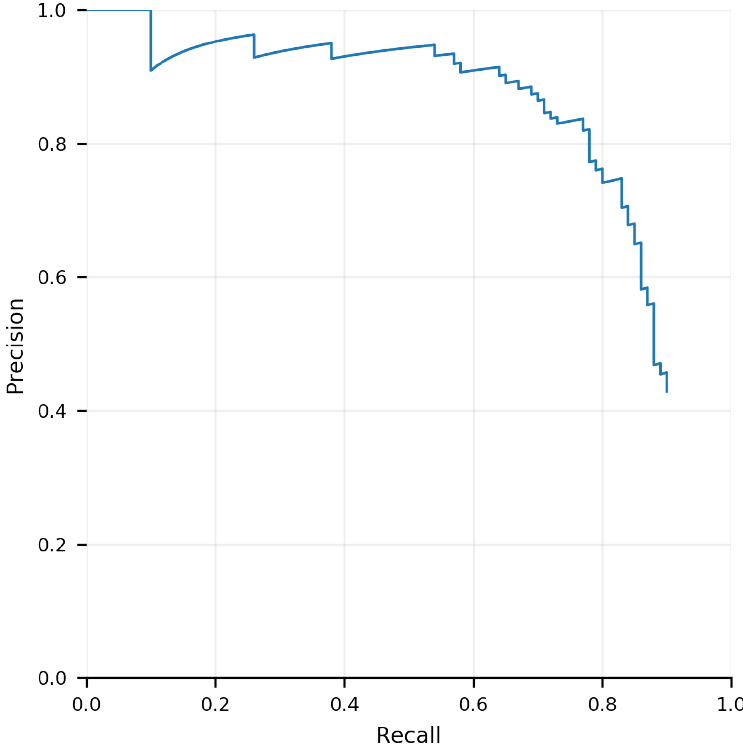
Figure 9. Precision-recall curve of the case study for small home systems in Rwanda RTI